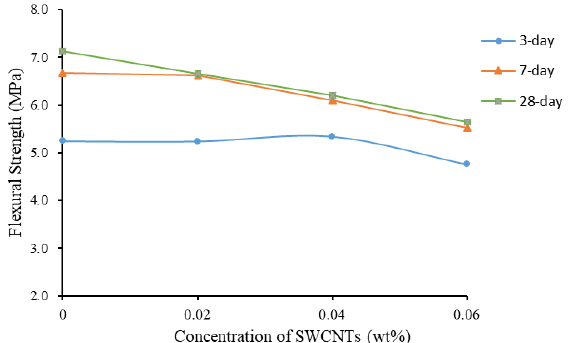
Figure 9. Flexural strength as a function of concentration of SWCNTs (No TX10).